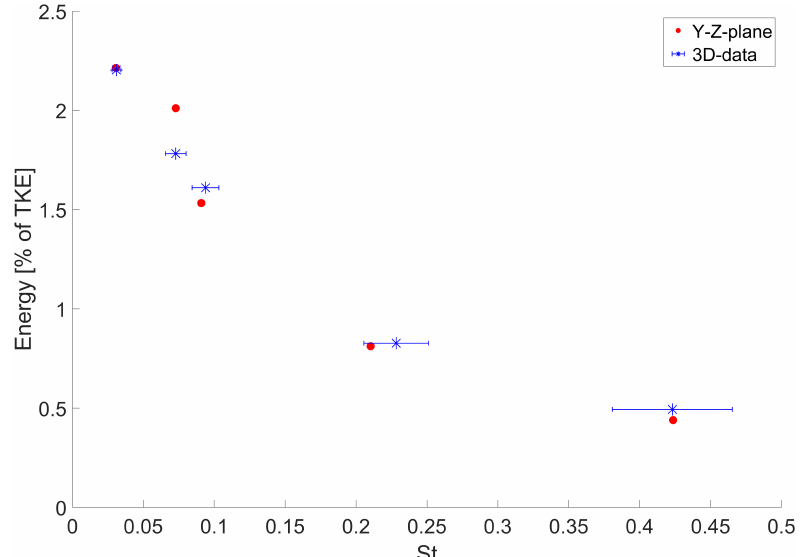
Figure 4. The Strouhal number and energy content of the 5 highest harmonic correlated modes for the 3D data and 5 closest matches of the Strouhal number of YZ-plane data, with error bars of 10%